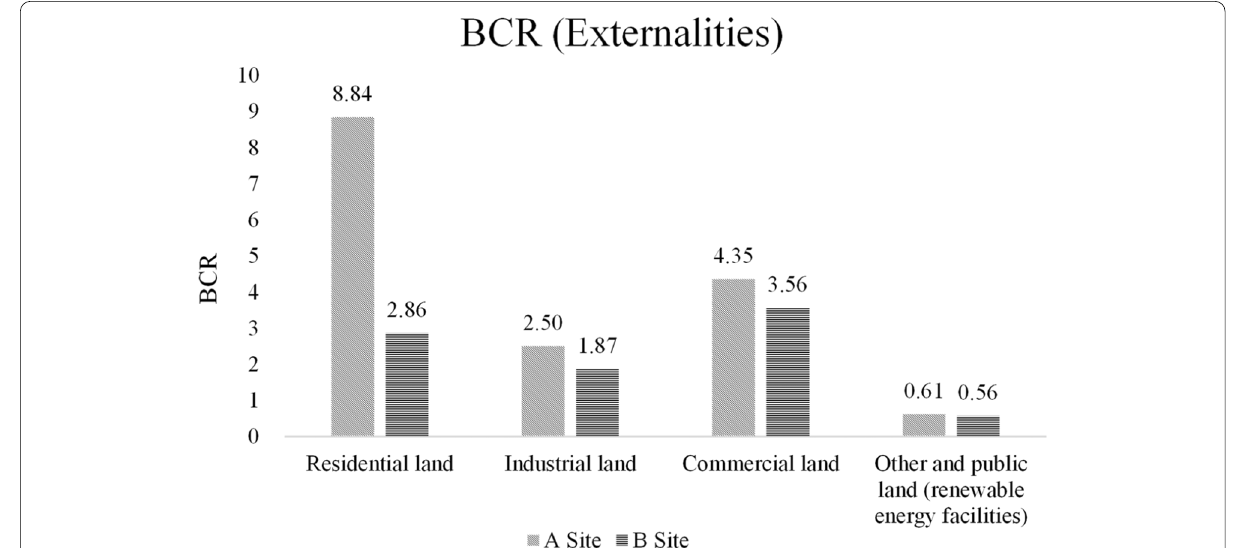
Fig. 8 The externalities benefit‑cost ratios of the two sites in four